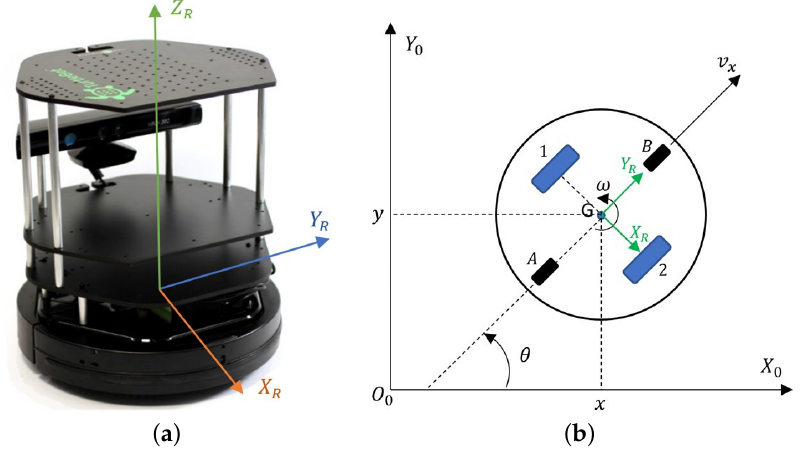
Figure 2. ( a ) Isometric view of the TURTLEBOT 2 robot with the coordinate system; ( b ) kinematic structure to determine the kinematic